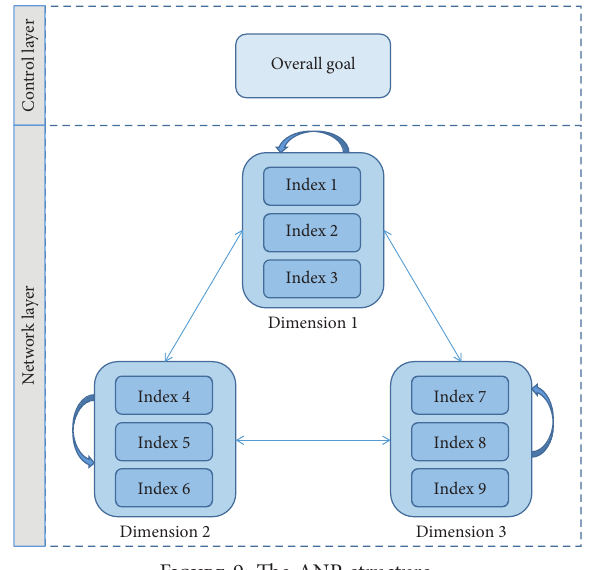
Figure 9: The ANP